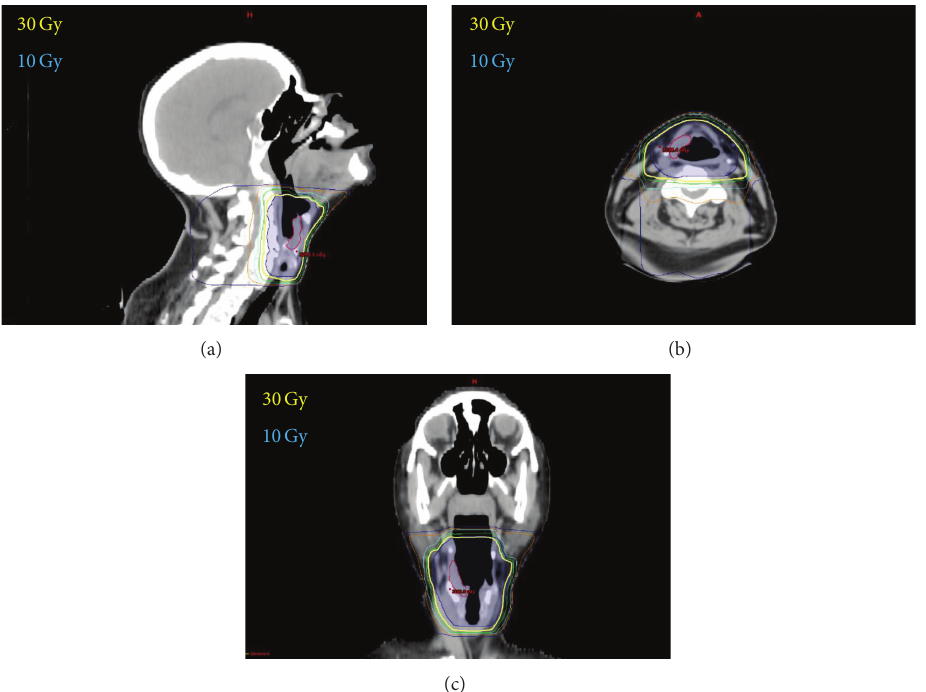
Figure 3: 3D conformal radiation therapy of MALT lymphoma of the larynx. Dose distribution in the saggital (a), axial (b), and coronal (c) planes. Yellow line represents the 30 Gy isodose line.